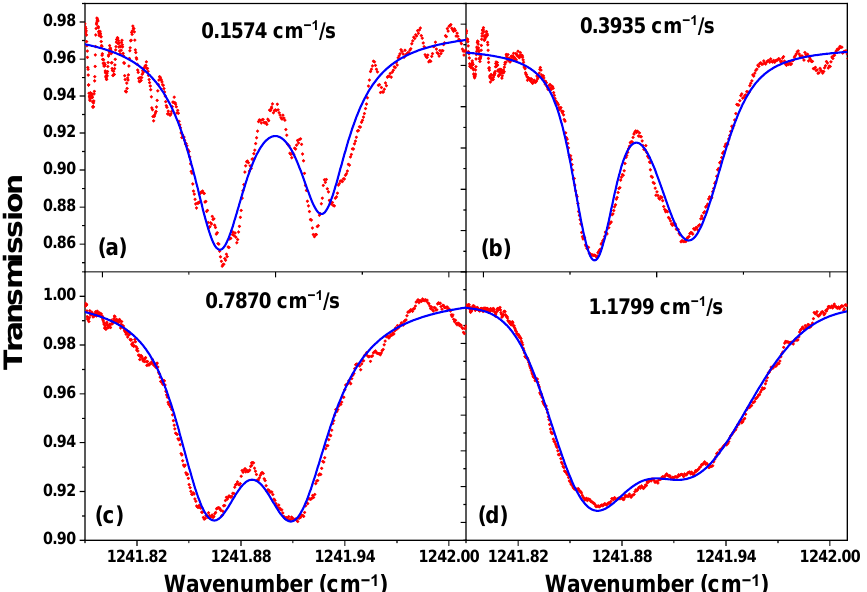
Figure 9. Heterodyne absorption spectra of CH 4 (red) at scanning speeds of 0.1574 cm − 1 /s ( a ), 0.3935 cm − 1 /s ( b ) , 0.7870 cm − 1 /s ( c ),and 1.1799 cm − 1 /s ( d ), respectively, fitted with Voigt profiles (blue).